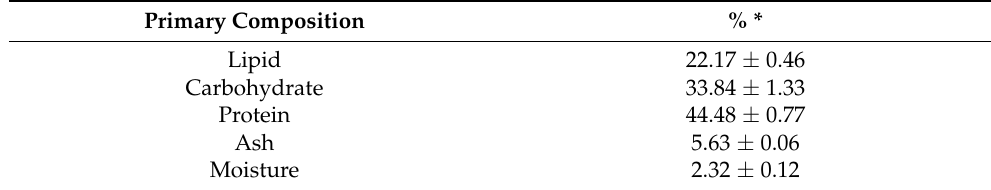
Table 5. Primary composition of the commercial C.vulgaris biomass as reproduced from Geor- giopoulou et al. [34] licensed under CC BY 4.0. Primary Composition % * Lipid 22.17 ± 0.46 Carbohydrate 33.84 ± 1.33 Protein 44.48 ± 0.77 Ash Moisture 2.32 ± 0.12 * All values except moisture are expressed on dry basis